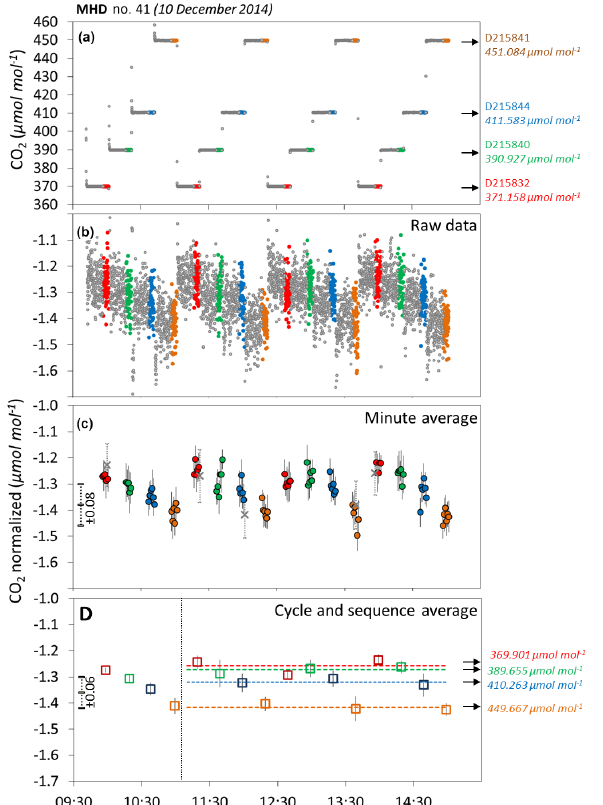
Figure 8. Details of a CO 2 calibration performed at Mace Head sta- tion (instrument no. 41) on 10 December 2014. (a) Raw CO 2 data measured for four calibration tanks analyzed four times in 20min. Gray points show the rejected values during the stabilization pe- riod (i.e., flushing period). Values indicated on the right give the tank ID and their attributed mole fractions on a WMOx2007 scale. (b) Same as (a) for CO 2 mole fraction differences between mea- sured values and attributed WMO values. (c) Same as (b) for 1min averages. Gray crosses show rejected values due to a standard devia- tion higher that the threshold value (vertical bar on the left). (d) Cy- cle (squares) and calibration sequence averages (dashed lines and values on the right). The first cycle is rejected as a stabilization pe- riod.